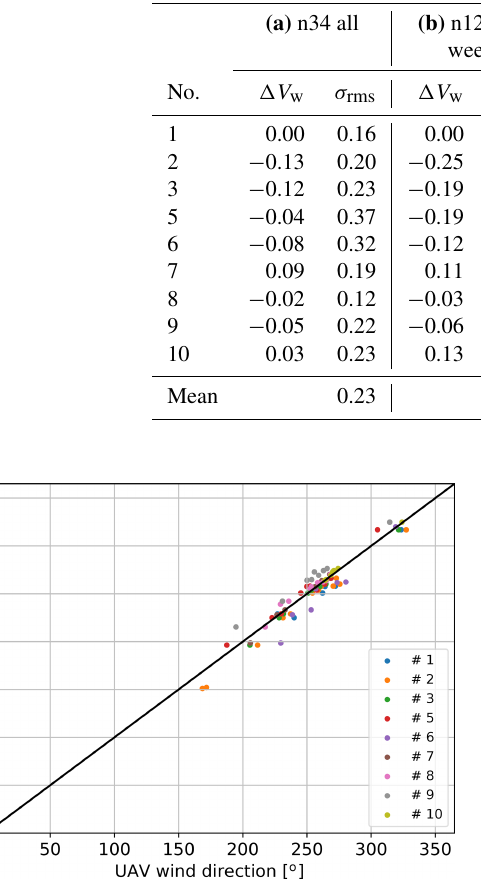
Figure 6. Average wind direction for n = 12 flights from the second week drone vs. tower including offset